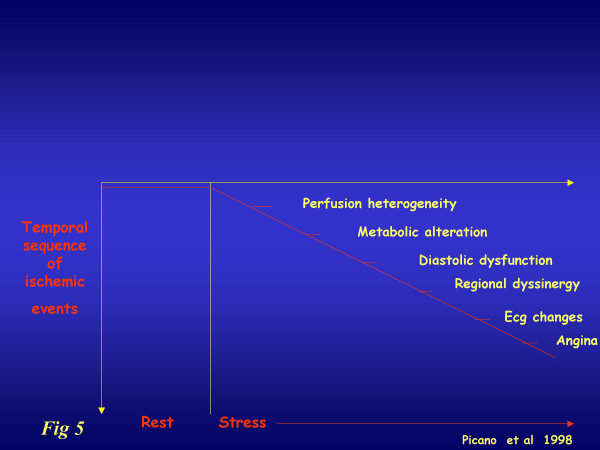
The classical ischemic cascade, triggered by coronary vasospasm and/or epicardial stenosis. The various markers are usually ranked according to a well-defined time sequence.